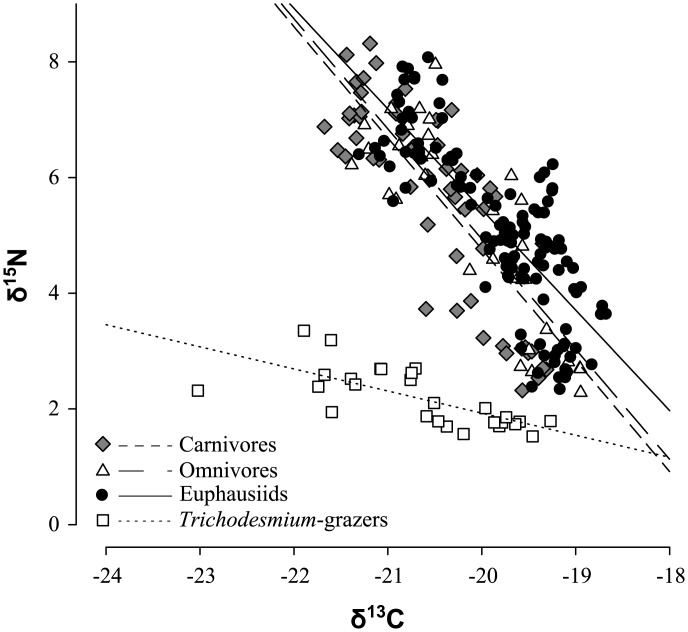
Negative linear relationship between individual bulk δ15N and δ13C values of zooplankton functional groups (Trichodesmium-grazer, carnivore, omnivore and euphausiids).